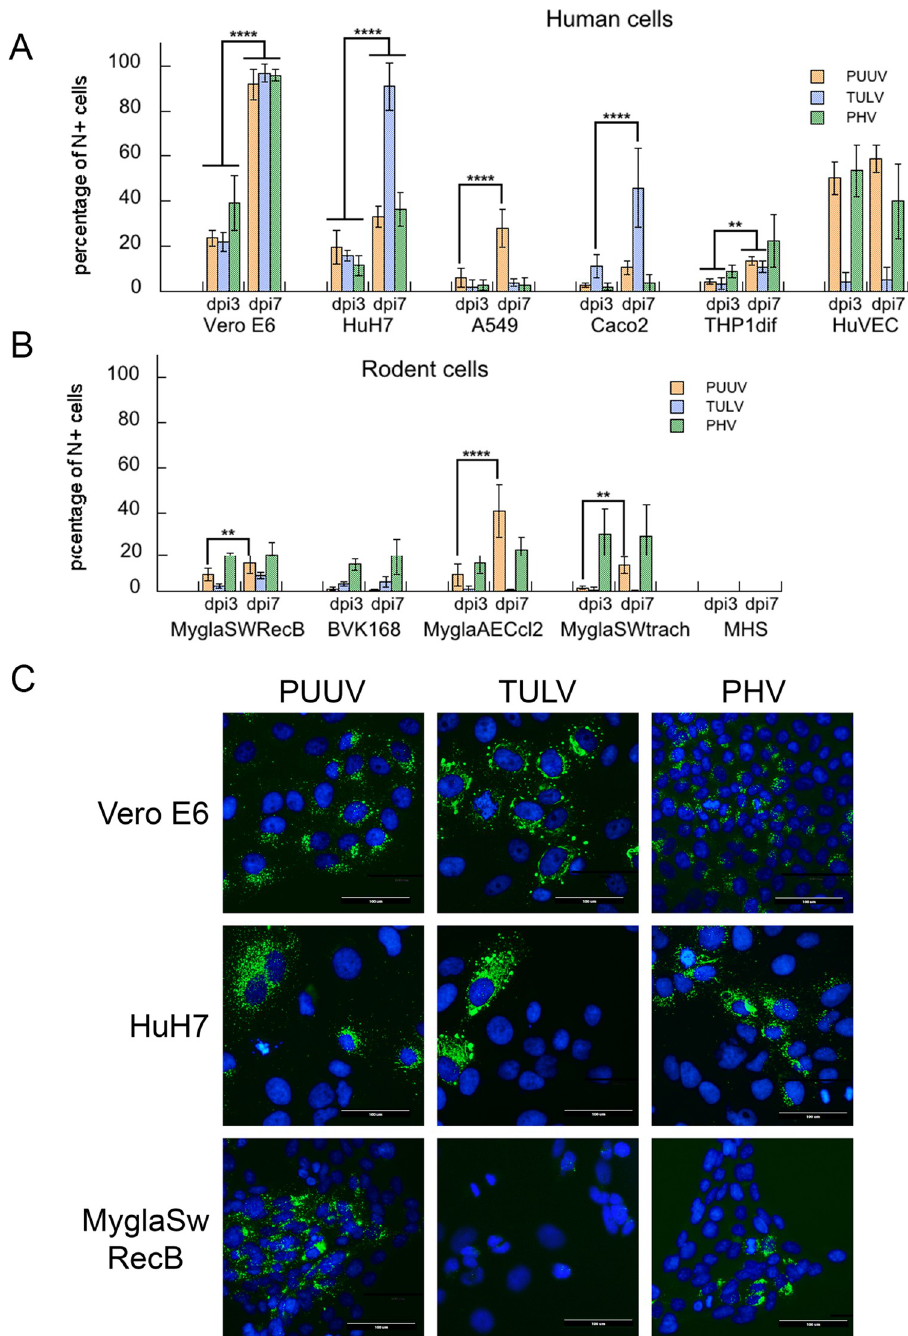
Fig 1. Susceptibility of human and rodent cells to orthohantavirus infection. Cells grown on glass coverslips were inoculated with a MOI of 1 with the different orthohantaviruses, then used at dpi3 and dpi7 for intracellular immunofluorescence staining of the viral N protein using the A1C5 monoclonal antibody to evaluate the infectivity of PUUV (orange bars), TULV (blue bars), and PHV (green bars). The histogram in (A) shows the percentage of infected cells (N+) of human origin derived from liver (HuH7), lung (A549), intestine (Caco2), as well as differentiated monocytes (THP1dif) and vascular endothelial cells (HUVEC). The non-human primate Vero E6 cells used to prepare virus stocks were added as a control. Histogram in (B) shows the susceptibility of rodent cell lines to orthohantaviruses, including renal cells (MyglaSWRecB and BVK168) and airway epithelia (MyglaSWTrach and MyglaAECcl2) from bank vole. The results were obtained from at least three independent experiments and the error bars correspond to standard deviation to the mean. Statistical analysis between dpi3 and dpi7 was performed using Two-way ANOVA